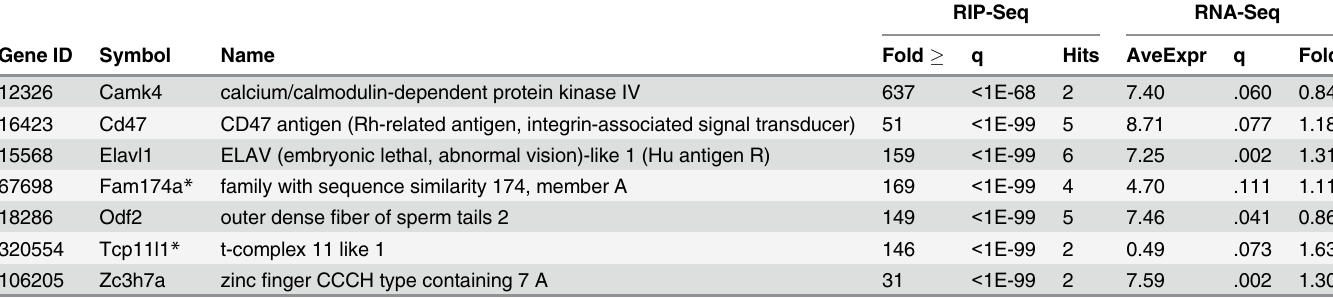
Table 3. Genes found in both RNA-Seq and RIP-Seq, sorted alphabetically. The seven protein-coding genes identified as significant based on RIP-Seq and RNA-Seq are given. For RIP-Seq, the total number of significant ‘ hits ’ (binding events) per gene are reported, counted across two independent RIP experiments. Fold denotes the minimum fold change observed across all of the hits, where fold change is expressed as (HuR/IgG), and q denotes the maxi- mum q-value (false discovery rate value based on method of Benjamini-Hochberg) from testing for HuR binding to RNA. Location of binding overlaps the annotated gene unless otherwise noted. For RNA-Seq, fold denotes change (HuR